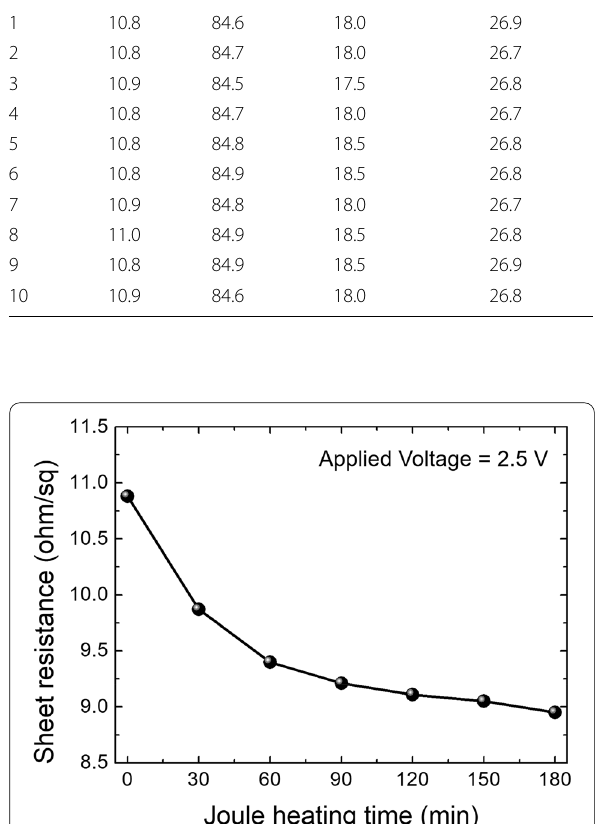
performance flexible/wearable THs [23, 30, 32, 35]. In addition, it was found that the thermal response time of